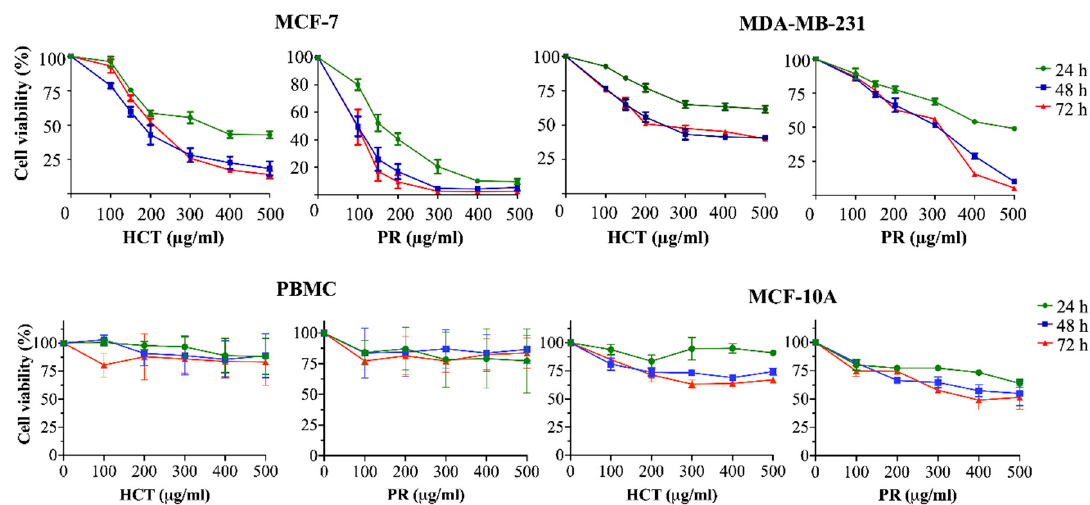
Figure 3. Cytotoxic effects of herbal extracts on breast cancer cells, PBMCs and MCF-10A cell line. The cells were treated with various concentrations (100–500 µg/mL) of H. cordata and P. ribesioides extracts for 24, 48 and 72 h. Cell viability was evaluated by comparing with 0.5% DMSO treated control cell, after 24, 48 and 72 h of incubation. Results are presented as mean ± SD from three independent experiments.